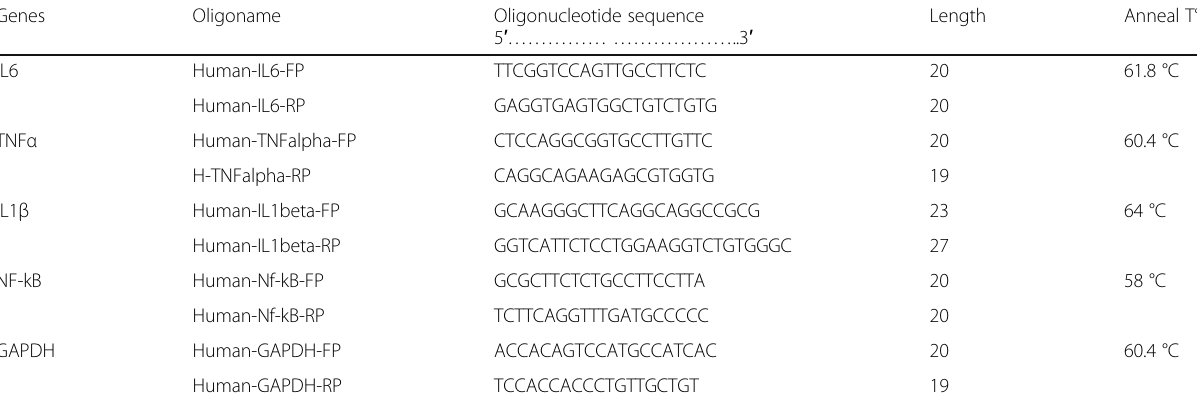
Table 1 Details of primer sequences (Sigma Genosys) used for inflammatory mediators gene expression through RT-PCR amplification